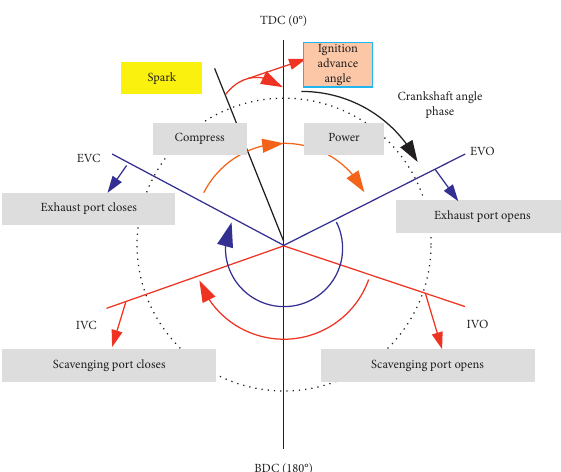
Figure 2: Working schematic diagram of the two-stroke